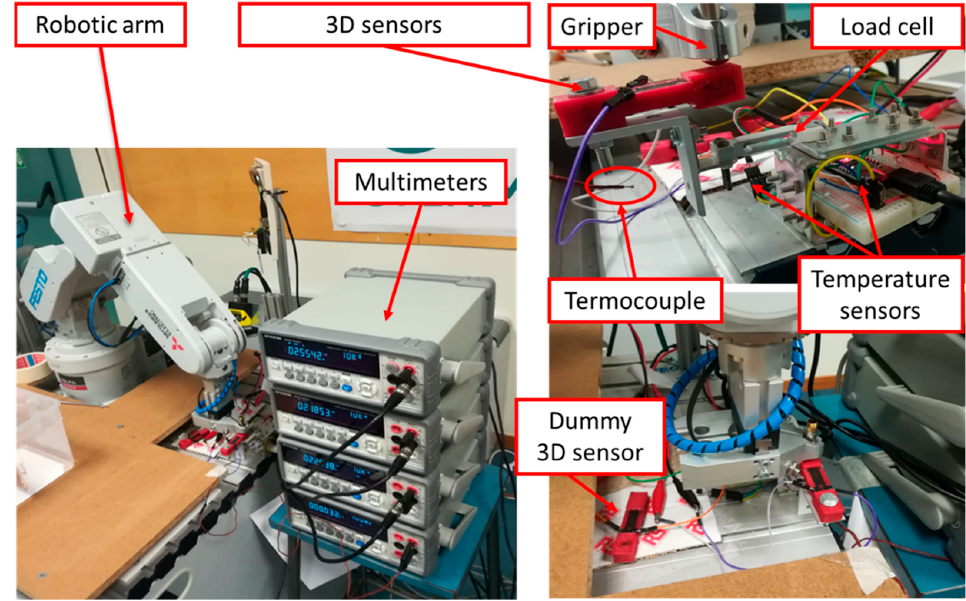
Figure 2. Experimental set-up.